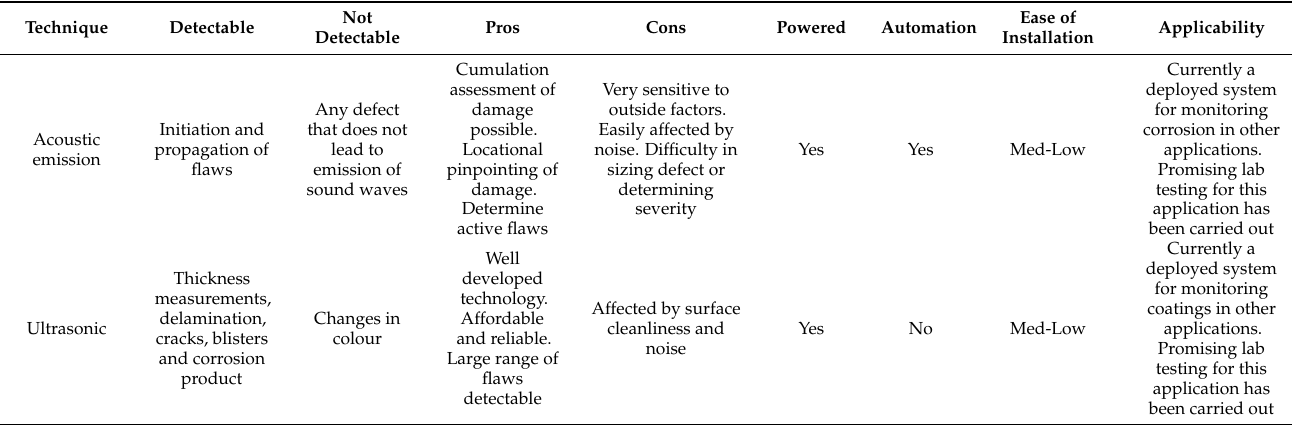
Table 7. Technique Table 7. Technique appraisal.